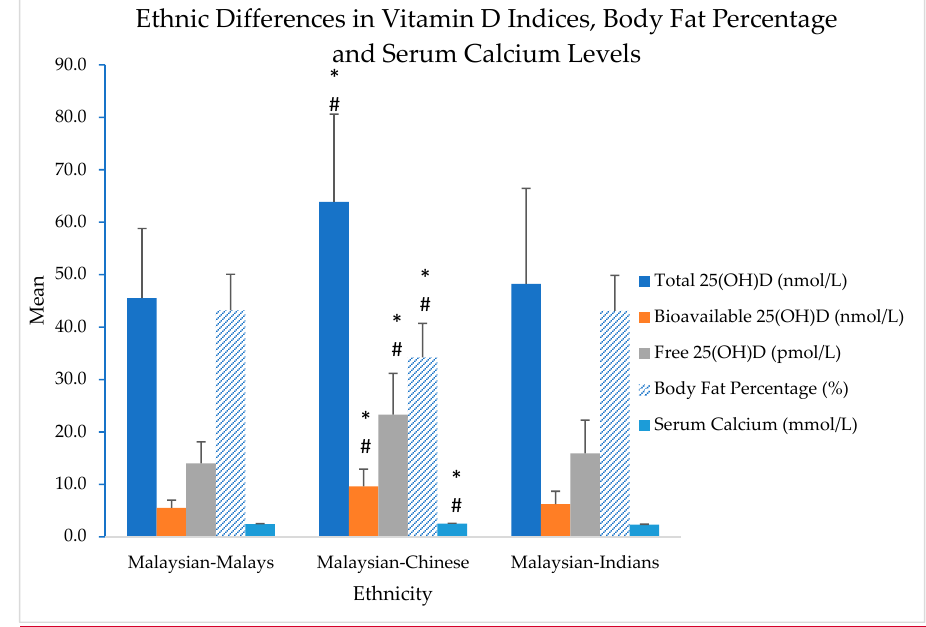
Figure 1. 25(OH)D indices, body fat percentage and serum calcium levels according to ethnicity; Malaysian-Malays, n = 49, Malaysian-Chinese, n = 35, Malaysian-Indians = 36. Error bars: + 1 Standard deviation, * analysed using one-way